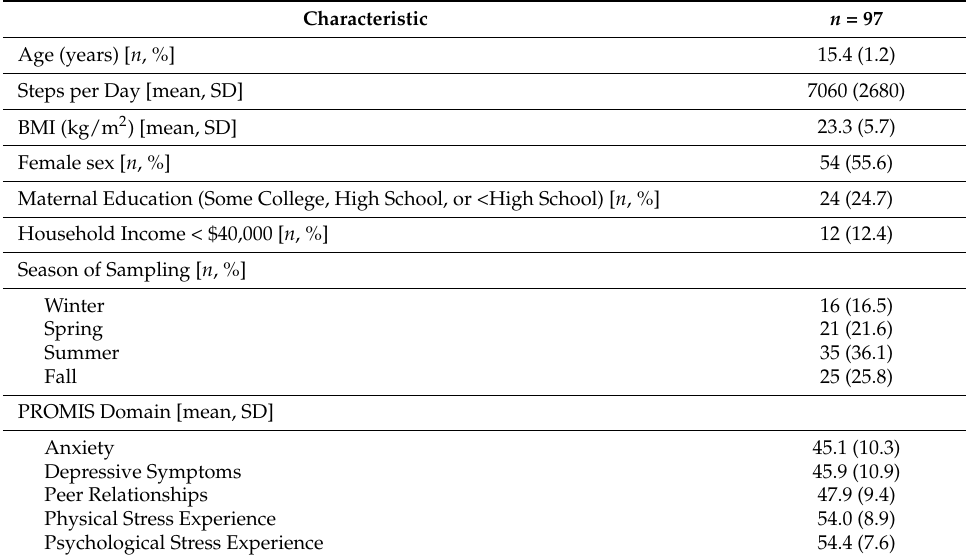
Table 1. Characteristics of the study population.